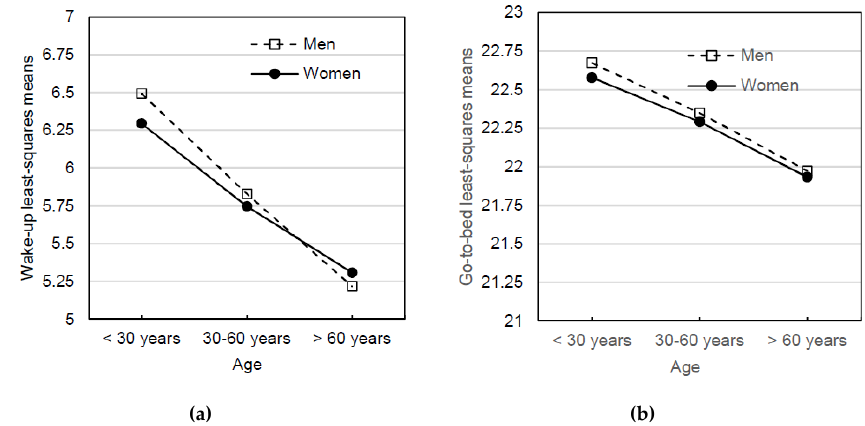
Figure 8. Interaction plots for the go-to-bed time and wake-up time with an interaction effect of age (years; < 30 (0), 30–60 (1), > 60 (2)) and sex (male (0), female (1)). (a) Wake-up time least-square means; (b) Go-to-bed time least-square means. ( b ) Go-to-bed time least-square